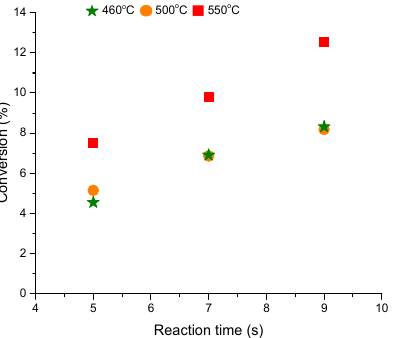
Figure 2. Average conversion, calculated from at least three injections with 95% confidence within ± 0.4, as a function of temperature 460–550 °C and reaction time 5–9 s. The data is obtained from the riser simulator.